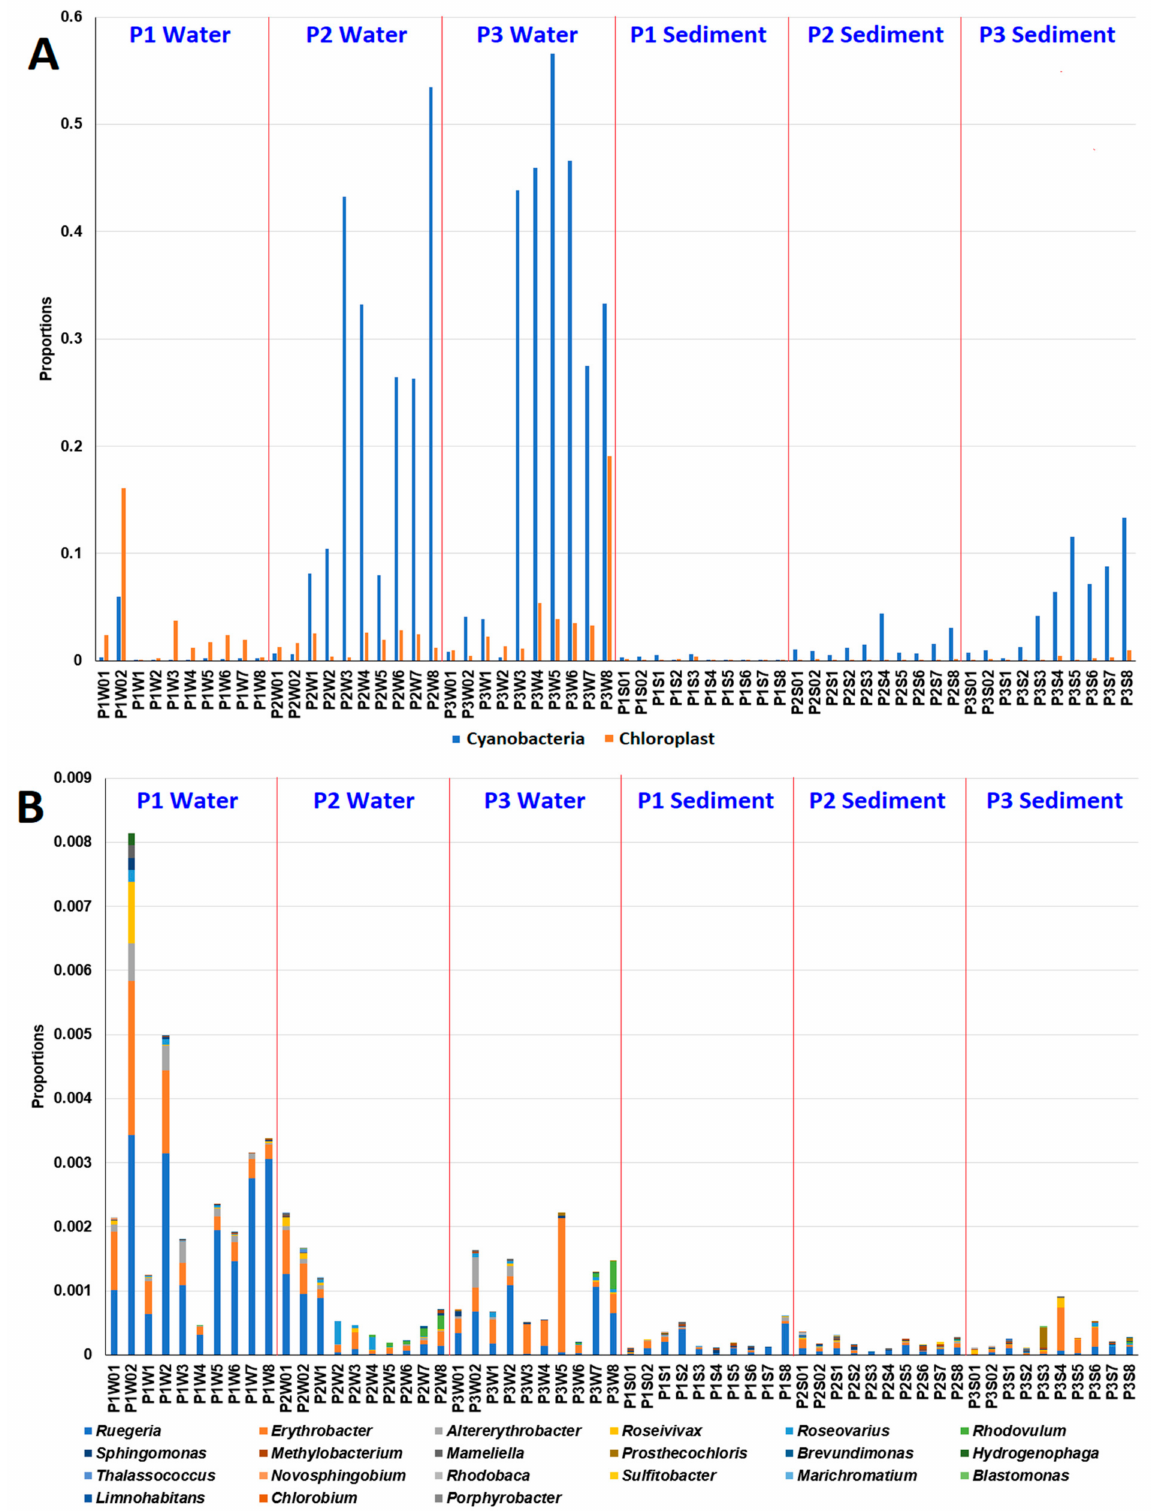
Figure 7. Proportions of phototrophic microbial communities. ( A ) Cyanobacterial and algal and communities and ( B ) anoxygenic phototrophic bacterial communities among the water and sediment of small milkfish ponds. P1: control small milkfish pond. P2: small milkfish pond with the addition of MG. P3: small milkfish pond with the addition of MG and MG-degrading